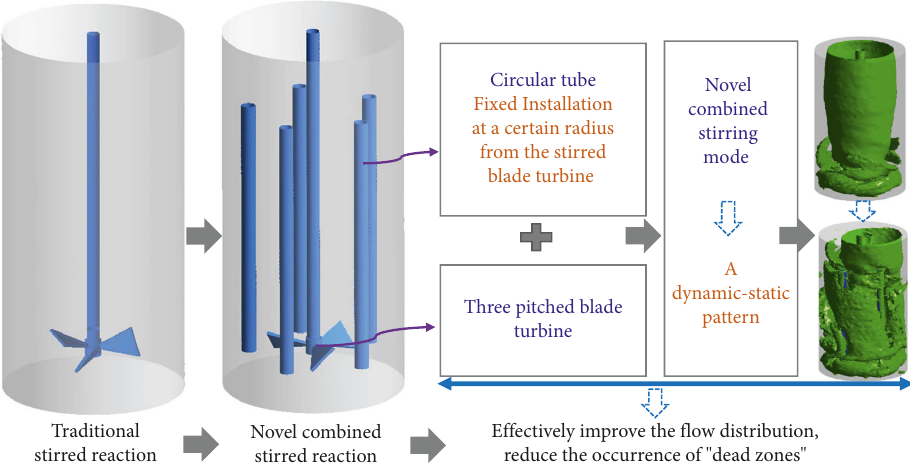
Figure 16: Analysis of dynamic-static coupling strengthening solid-liquid mixing.